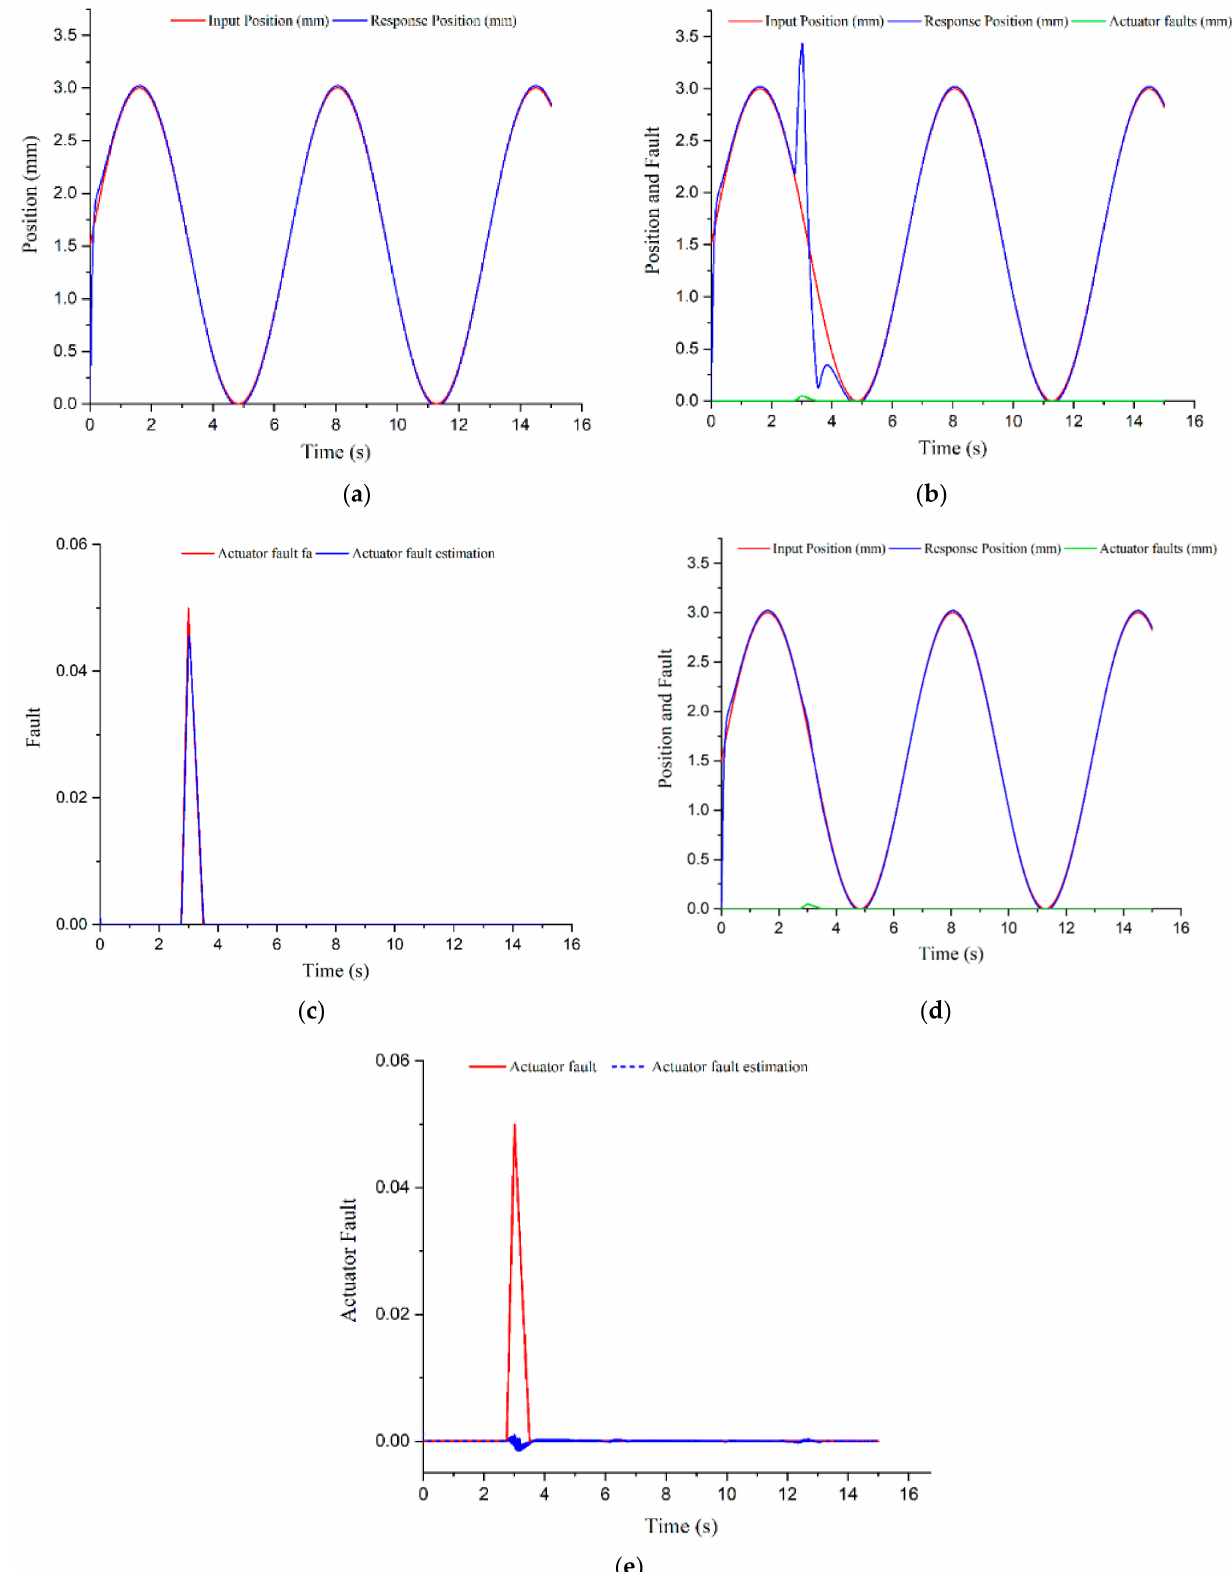
Figure 3. Simulation results of EHA system under the actuator fault impact. ( a ) Without faults. ( b ) Position response for the case without actuator fault compensation. ( c ) Actuator fault estimation for the case without actuator fault compensation. ( d ) Position response for the case with actuator fault compensation. ( e ) Actuator fault estimation for the case with actuator fault